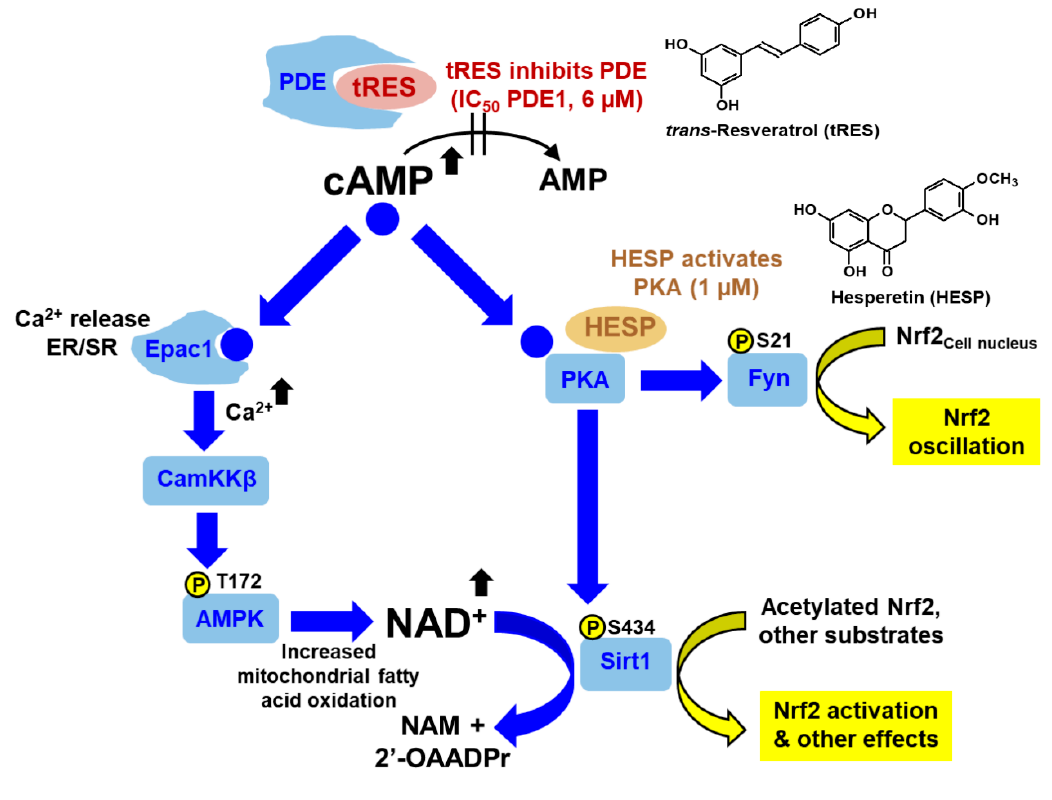
Figure 3. Putative upstream mechanism for activation of transcription factor Nrf2 by tRES-HESP. Abbreviations: AMPK; AMP-dependent kinase; CamKKß, calcium/calmodulin-dependent protein kinase kinase-beta; Epac1, exchange protein directly activated by cAMP 1; ER, endoplasmic reticulum; Fyn, NAM, nicotinamide; 2 ′ -OAADPr, 2 ′ - O -acetyl-ADP-ribose; PDE, cAMP phosphodiesterase; PKA, protein kinase A; sirt1; sirtuin-1; and SR, sarcoplasmic reticulum.